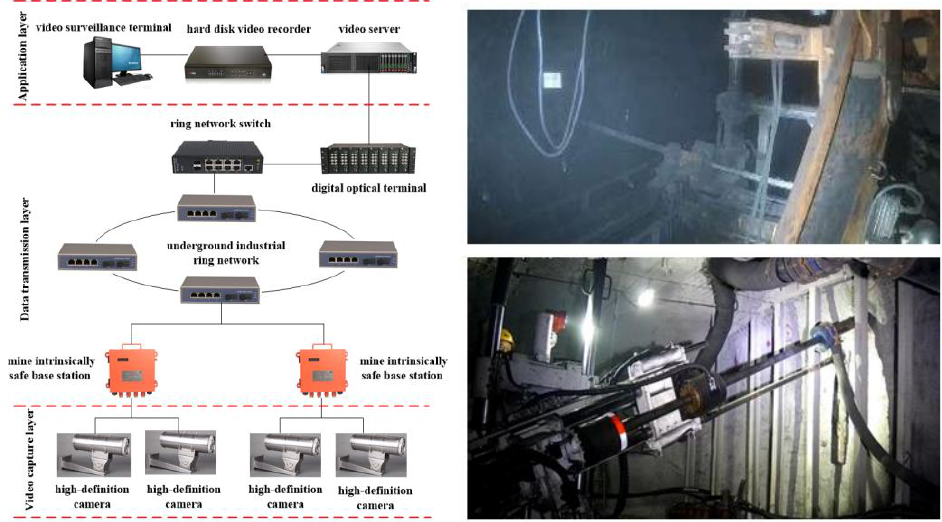
Figure 4. Network topology diagram of drilling video surveillance system and monitoring effect.